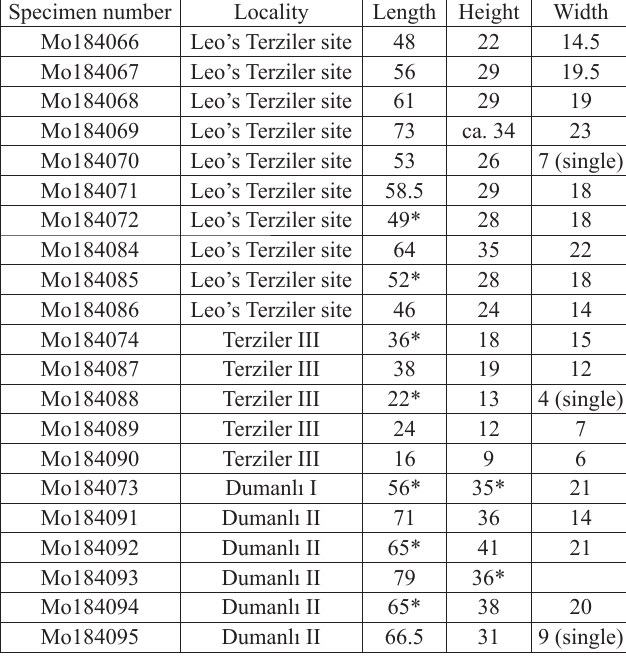
Table 3. Measurements (in mm) of Aksumya krystyni sp. nov., * incom-